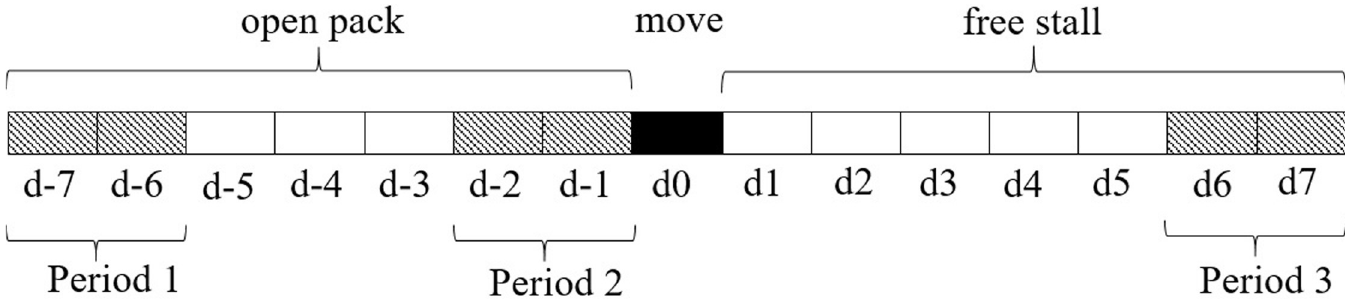
Fig 1. Summary of data collection days in the open pack and free stall pen. Shaded squares indicate days of data collection (5-minute instantaneous scan sampling for 24-h duration). The black square marks the day when dairy calves were moved to the new housing system.